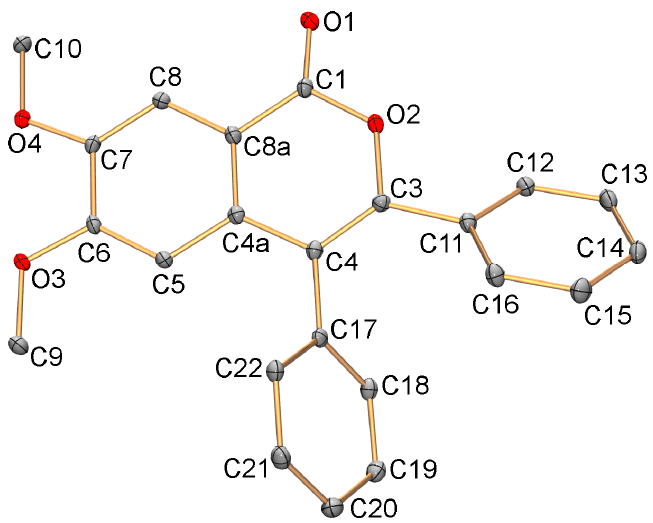
Figure 3. Structure of compound 3ba’ (one of two symmetry-independent molecules). Ellipsoids are shown at the 50% level. Hydrogen atoms are omitted for clarity. Selected bond lengths (Å) for the first/second symmetry-independent species are as follows: C1-O1 1.213(2)/1.211(2), C1-O2